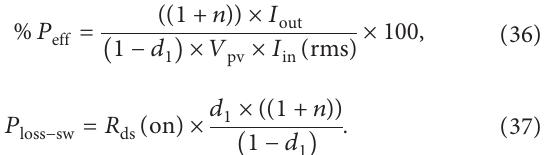
Figure 15: SIDO mode results (scale: 5V/DIV, 2 A/DIV, and 2.5 us/DIV). (a) Gate signals V (b) Gate signals V and V and blocking voltage V GS1 GS2 and V and current i of diode D c . (e) Gate signals V signals V GS1 GS4 dc and current i of diode D dc2 c2